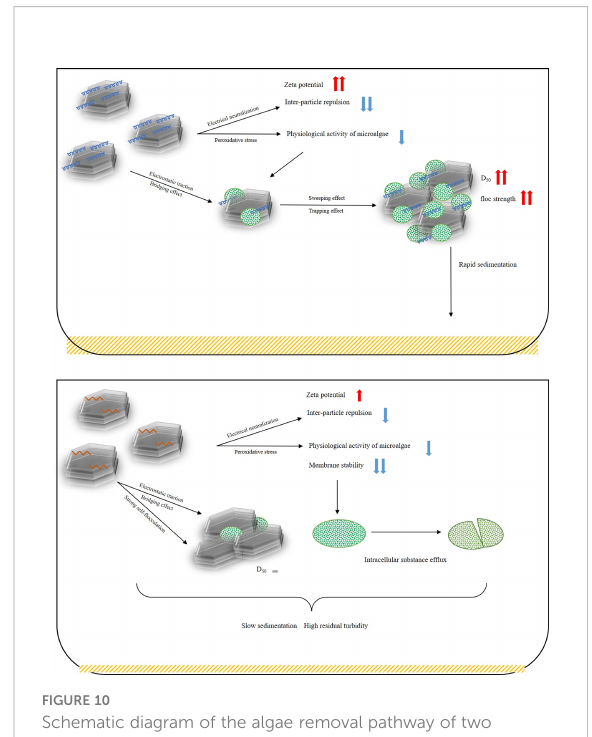
FIGURE 10 Schematic diagram of the algae removal pathway of two modi fi ed clays (MP and